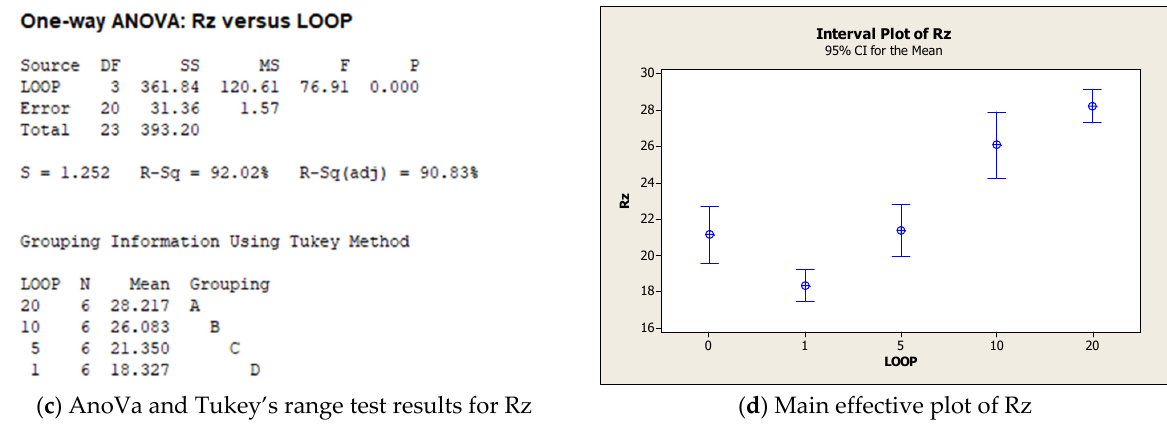
Figure 10. Main results of statistical analysis for the third experimental series. ( a ) AnoVa and Tukey’s range test results for Ra; ( b ) Main effective plot of Ra; ( c ) AnoVa and Tukey’s range test results for Rz; ( d ) Main effective plot of Rz.